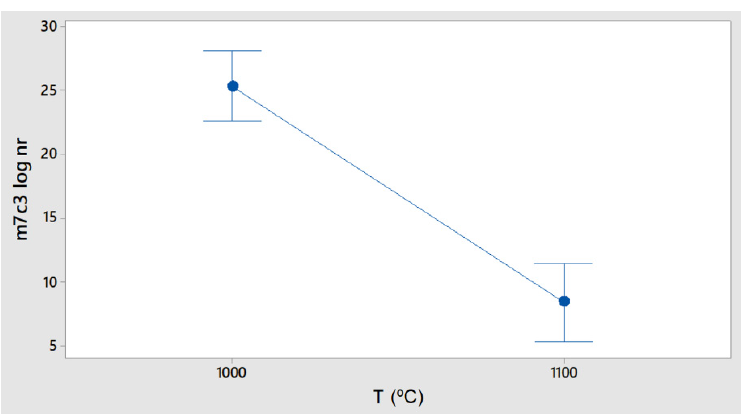
Figure 9. M 7 C 3 precipitates’ nucleation rate (m 3 /s) for the DOE Thermocalc simulation. Average effect of temperature (°C).